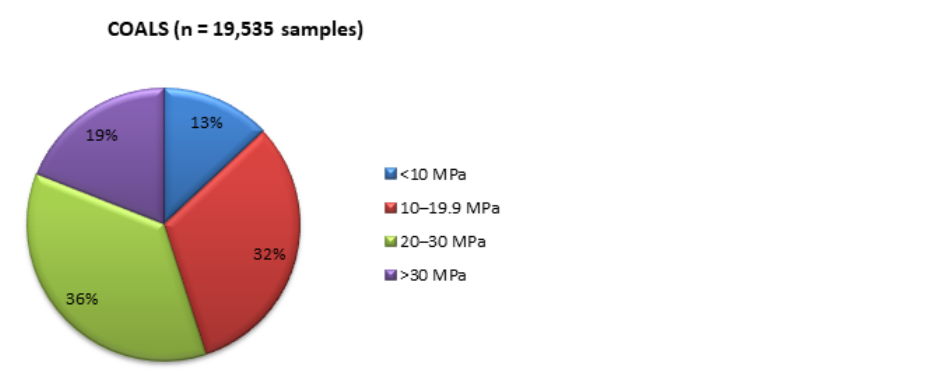
variability thresholds. Based on the results of [3]. Figure 5. Contribution of USCB coals with medium uniaxial compressive strength in the adopted